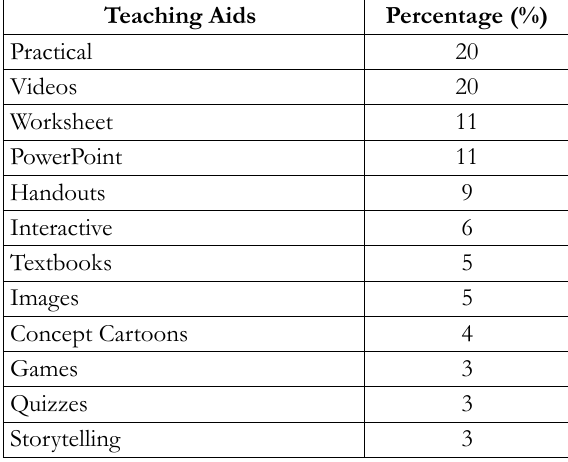
Table 4. Percentage of responses from teachers regarding teaching aids